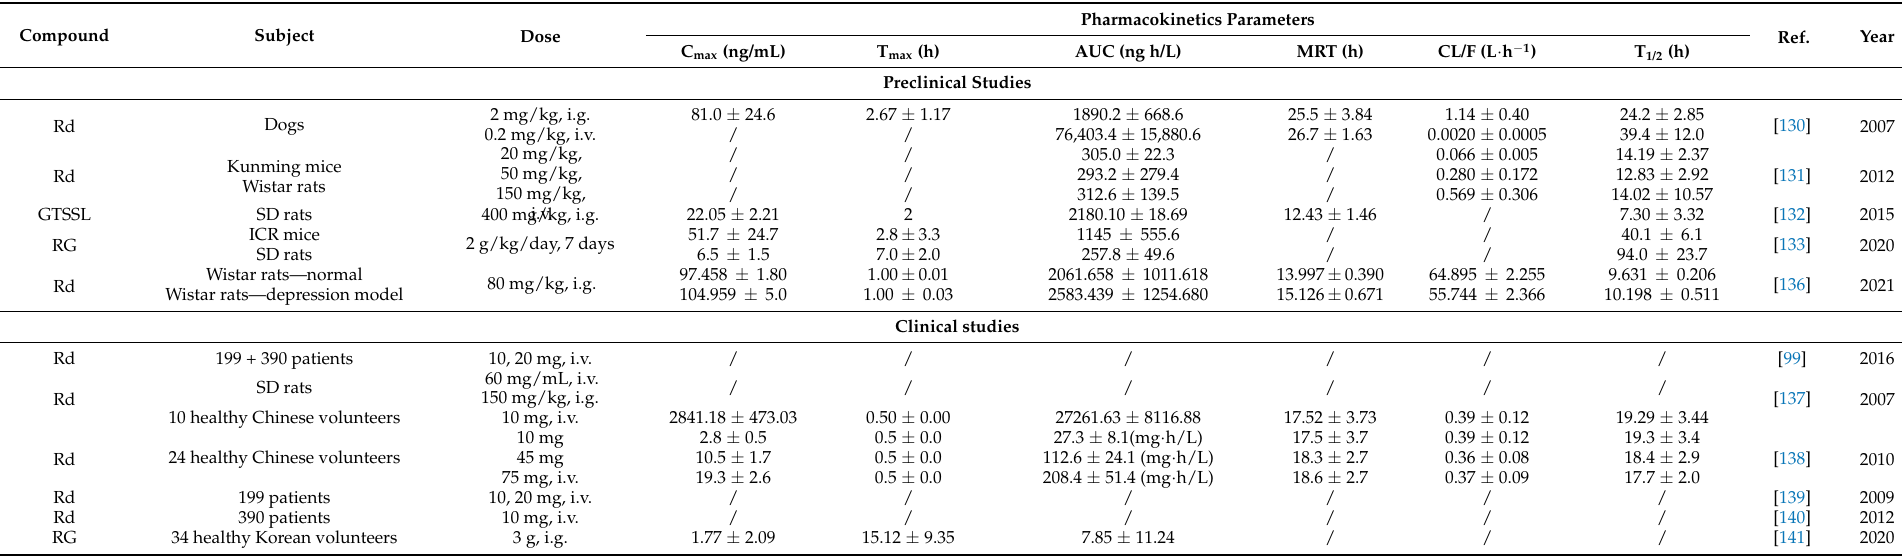
Table 7. Pharmacokinetics and clinical studies of